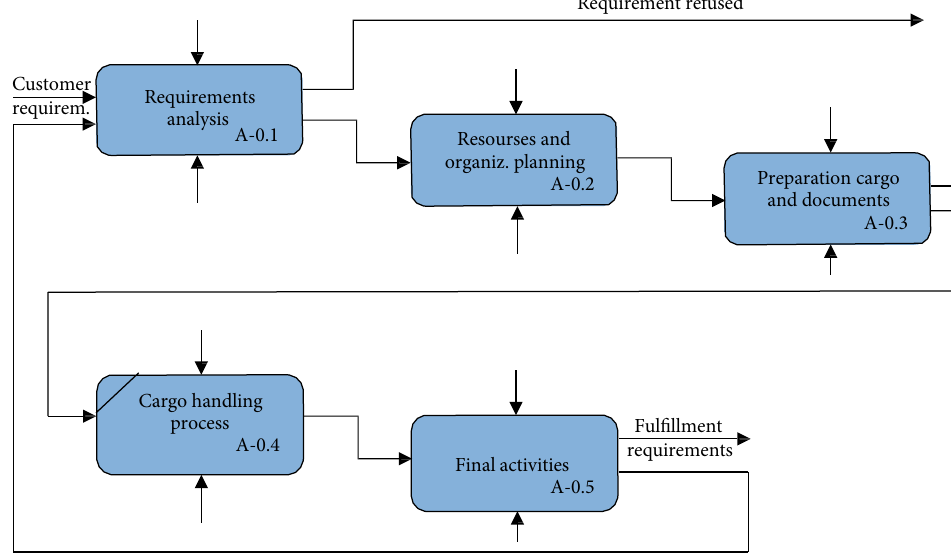
Figure 2: Diagram of Air Cargo Handling Process decomposition.